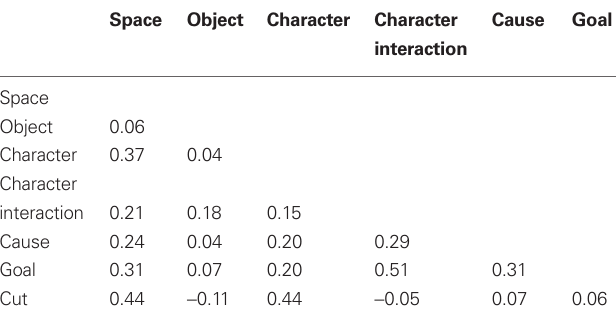
Table 1 | Correlations amongst the situation change